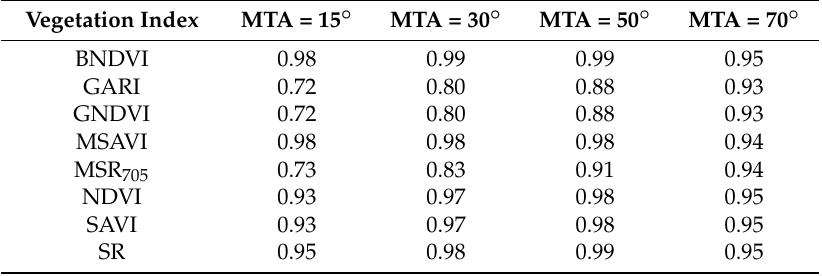
Table 5. Kendall’s rank correlation coefficient ( τ k ) between vegetation indices and LAI in PROSAIL-simulated data for different MTA values at a fixed Cab (45–50 µ g cm − 2 ). All correlations were statistically significant ( p <